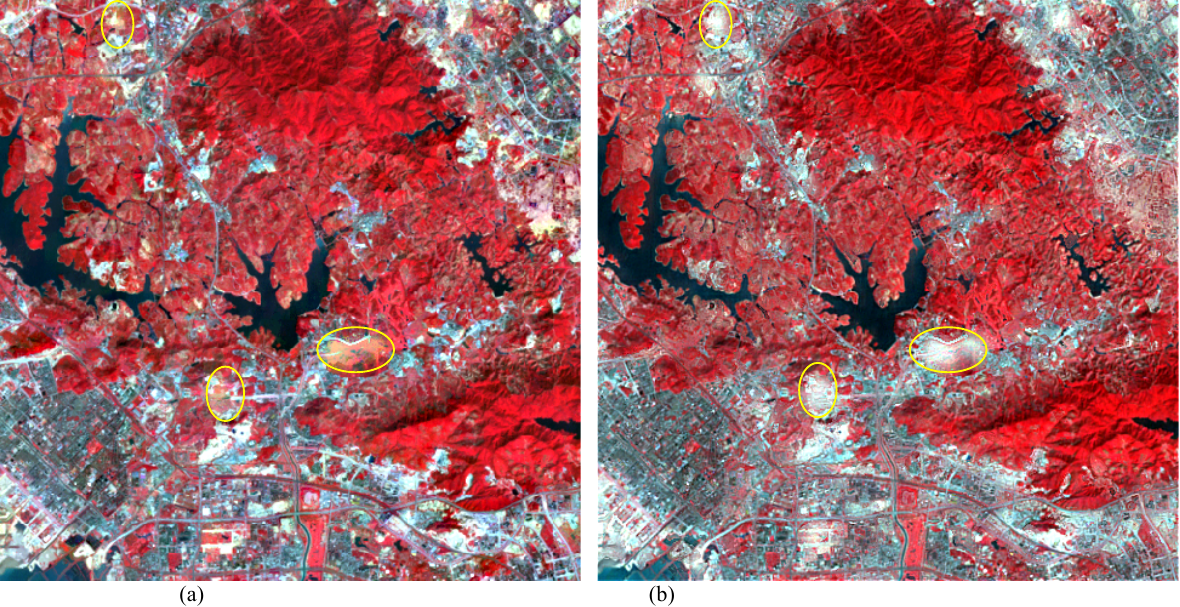
Figure 2. Comparison of the results by STARFM and AREC methods. (a) STARFM (b) AREC